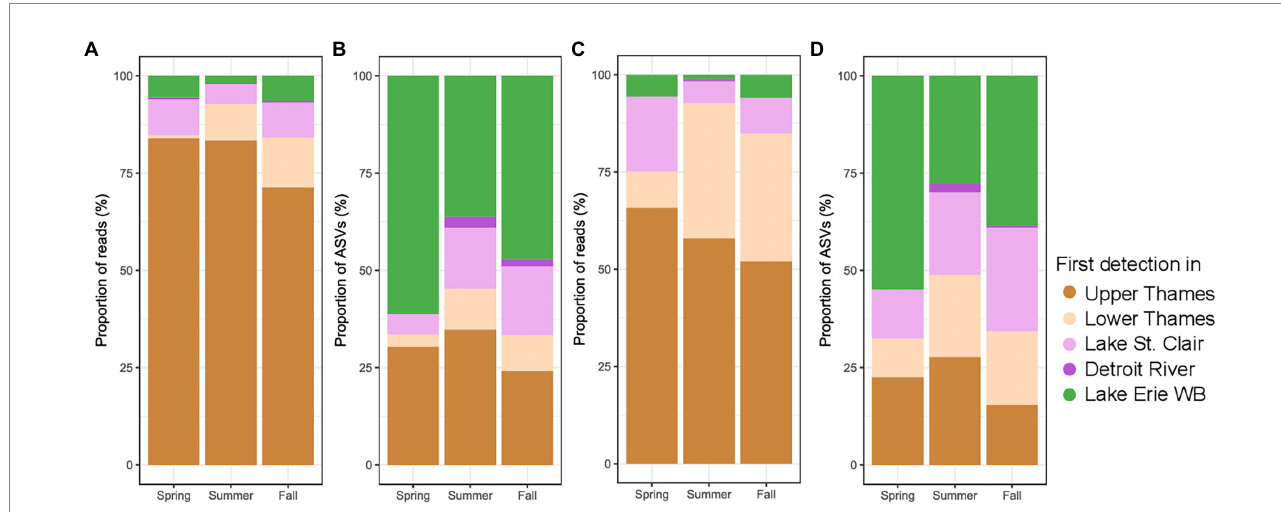
FIGURE 5 Proportion microbial reads (A) and ASVs (B) , as well as Cyanobacterial reads (C) and ASVs (D) in the Lake Erie Western basin at different season, classified as a function of the most upstream system they were first detected in (WB stands for Western Basin). Winter samples were removed due to lack of system